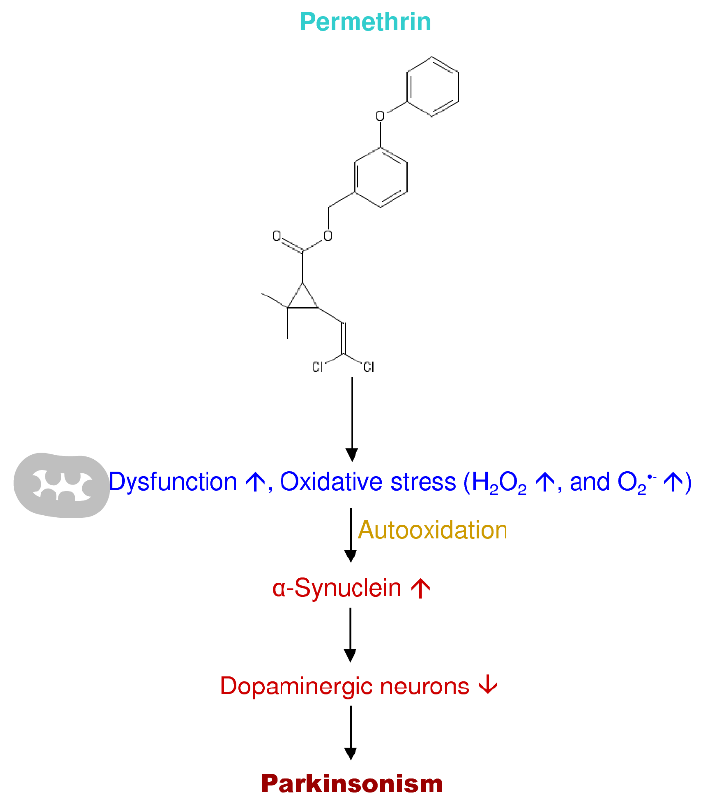
Figure 8. Putative mechanism of action of permethrin in PD progression.